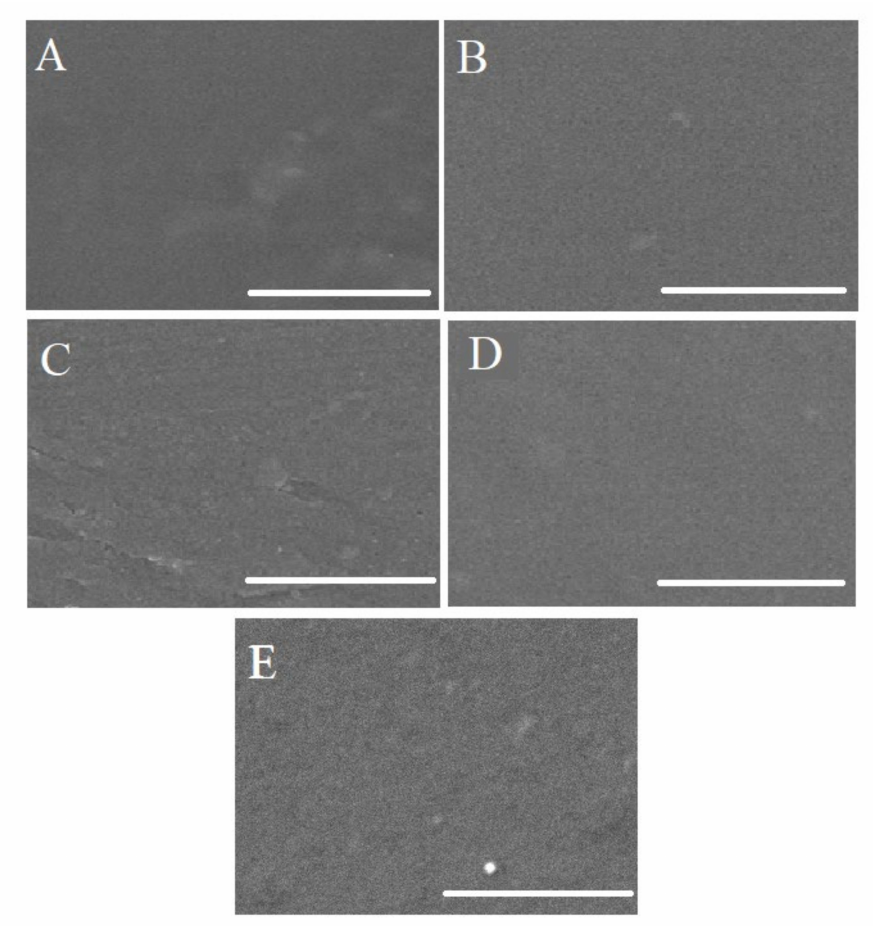
Figure 4. Surface morphology of ( A ) CTA:CDA (100:0), ( B ) CTA:CDA (0:100), ( C ) CTA:CDA (80:20), ( D ) CTA:CDA (60:40), and ( E ) CTA:CDA